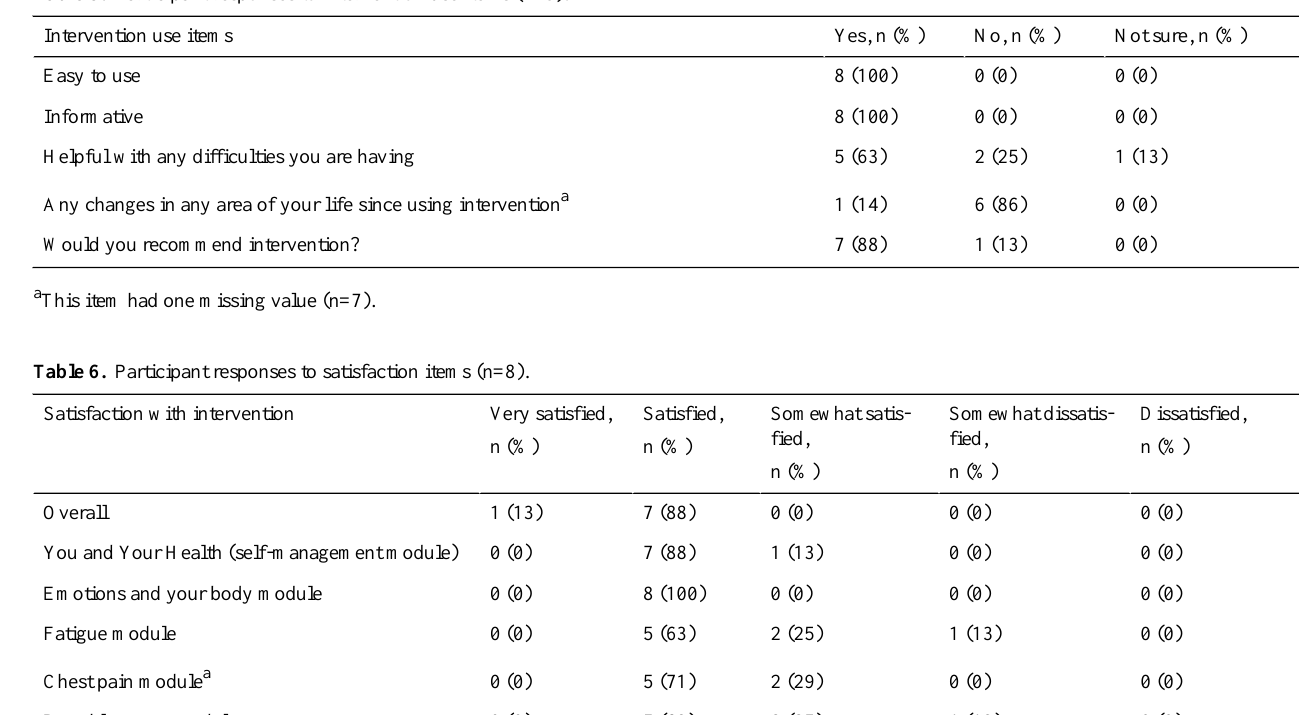
Table 5. Participant responses to intervention use items (n=8).